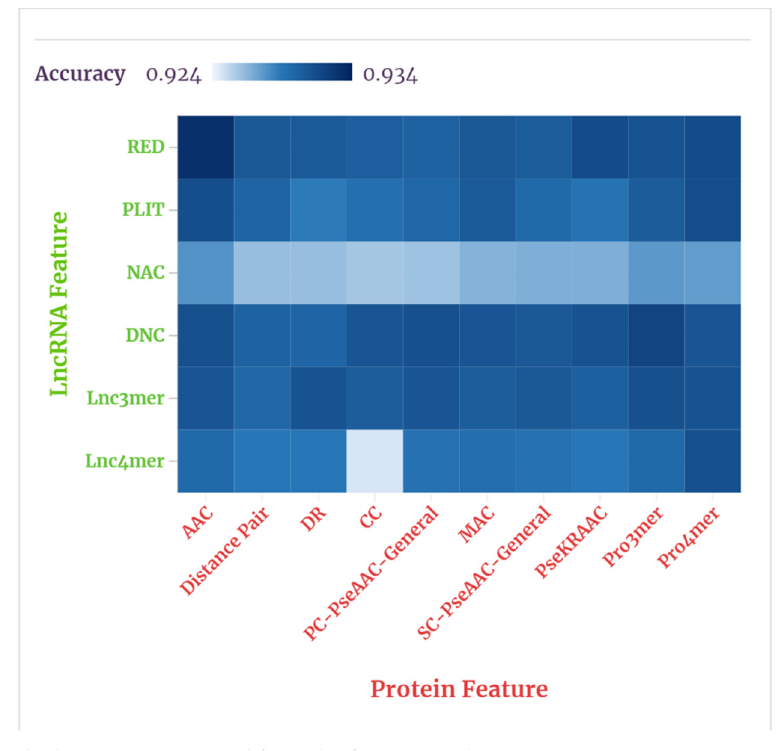
Figure 6. The heat map generated from the feature combinations in RPI21850.